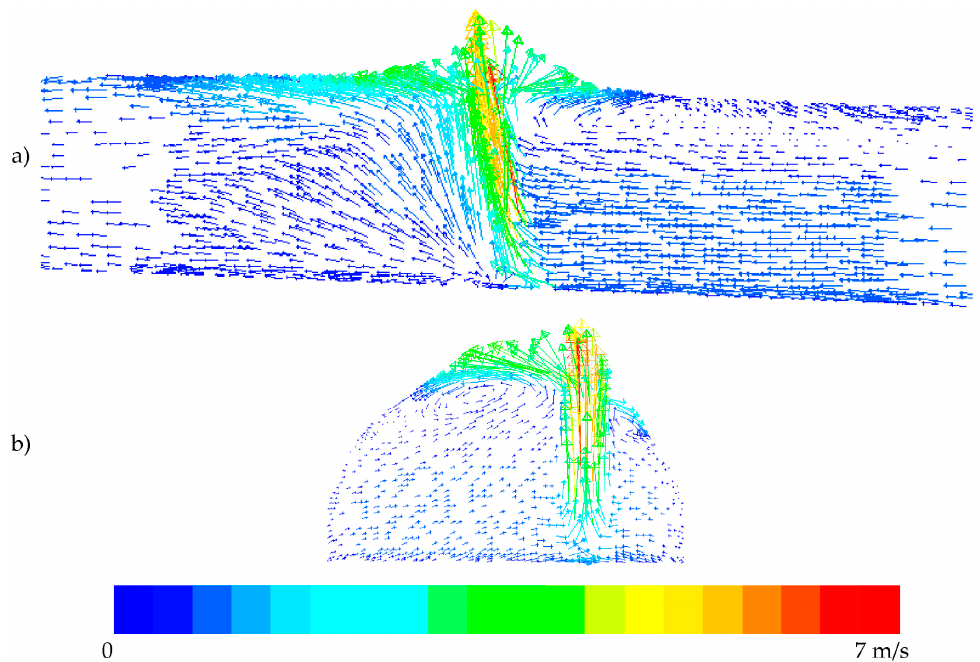
Figure 14. Visualization of velocity vectors in 160 s of fire development at two planes: ( a ) at the plane of fire source, ( b ) on a perpendicular cross-section at the leeward edge of trays.